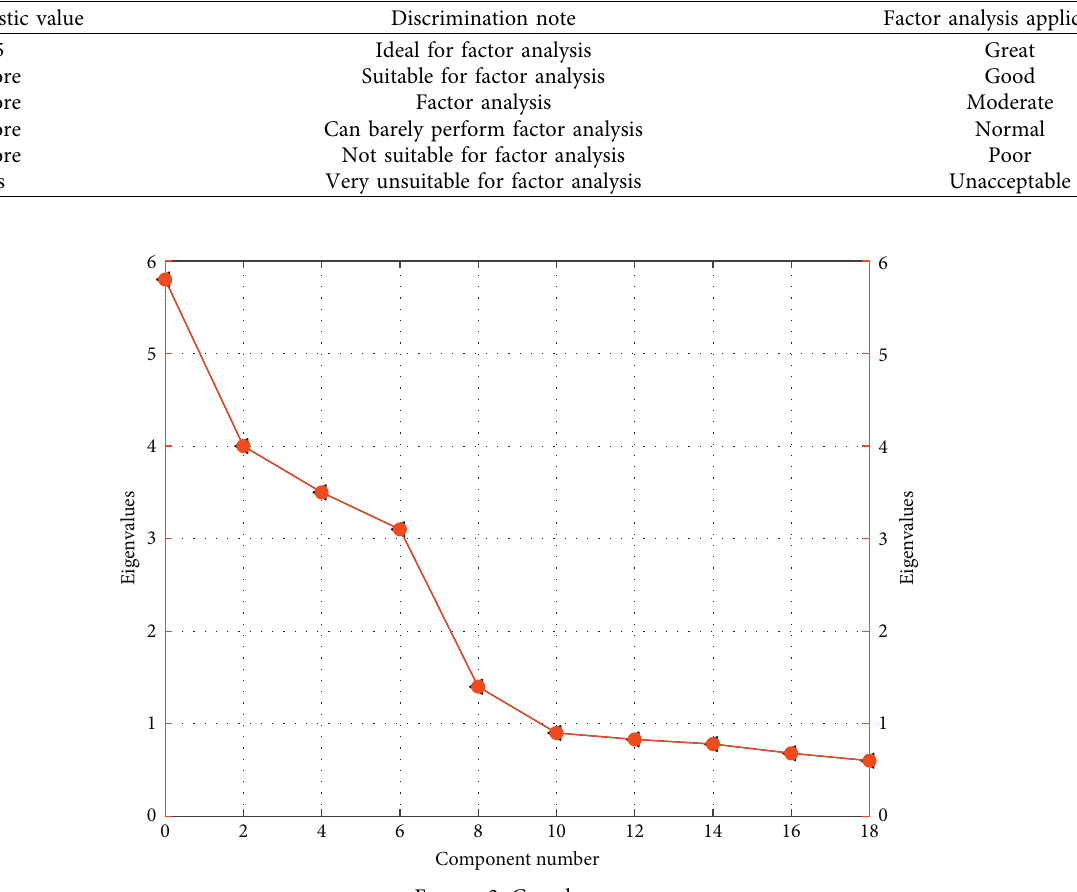
Figure 2: Gravel